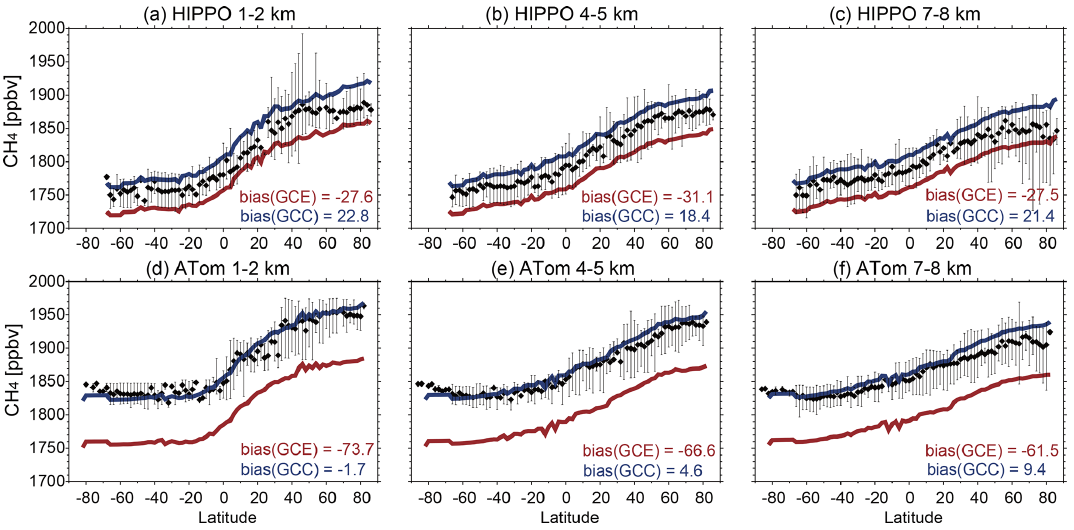
Figure 9. HIPPO and ATom aircraft-measured latitudinal gradients of CH 4 mixing ratios. Measurements from HIPPO (a–c) and ATom (d–f) flights are averaged in 2 ◦ latitude bins and at three altitude levels ( a, d : 1–2km; b, e : 4–5km; and c, f : 7–8km). The black symbols and bars represent the mean values and ranges for each bin. The corresponding model results from the GCE (with EDGAR anthropogenic emissions and interannually varying OH; red lines) and GCC (with CEDS and interannually varying OH; blue lines) simulations are also shown, and the values inset present the mean model biases relative to aircraft